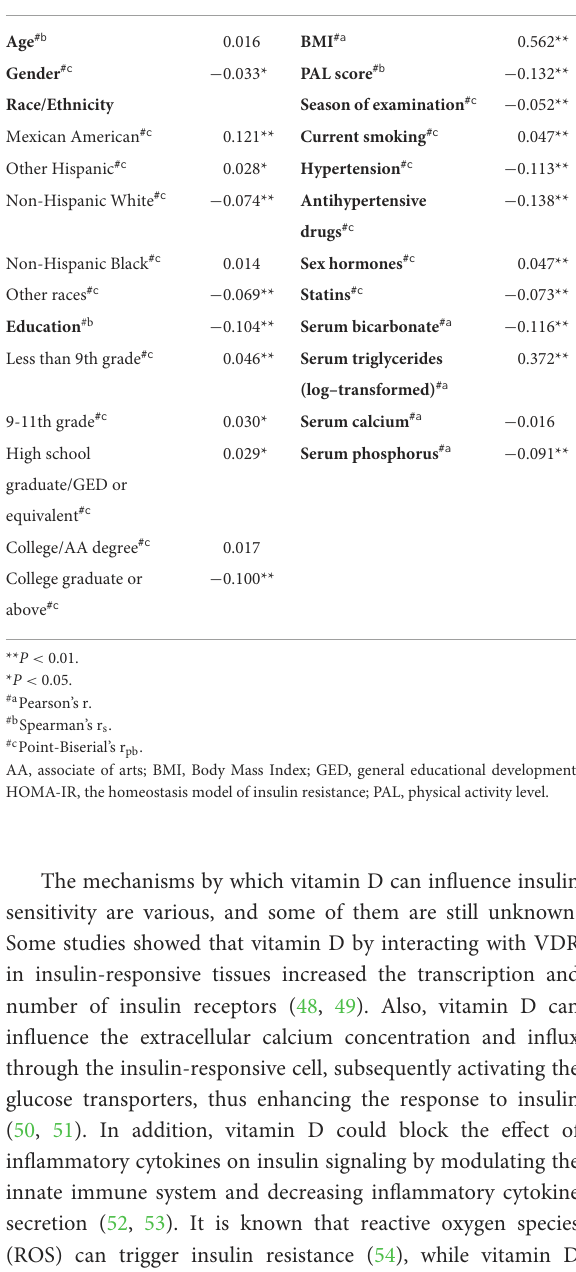
TABLE 2 Screening of covariates based on statistically significant association with log-transformed HOMA-IR.